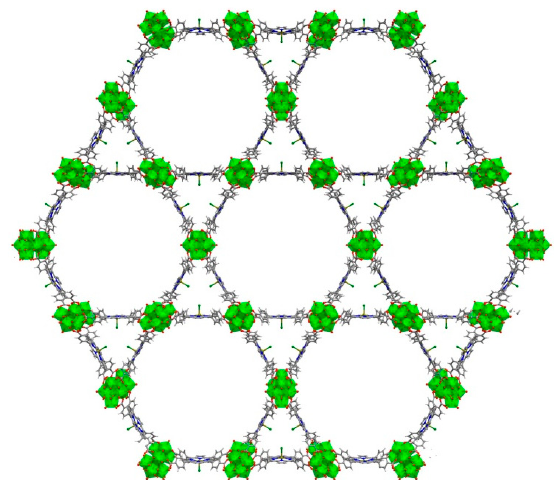
Figure 12. Schematic representation of the 3D network in Kagome-like topology of PCN-222(Fe) viewed along [0,0,1] direction. (Colour scheme: bright green = Zr, dark yellow = Fe, green = Cl, gray = H, dark gray = C, light blue = N, red = O,).